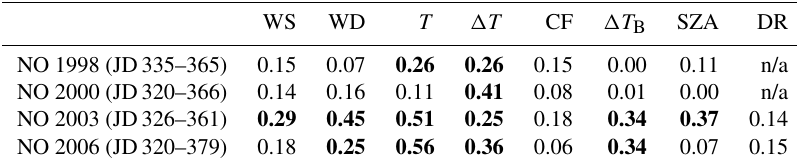
Table A1. Regression ( r 2 ) of meteorological variables with NO. r 2 > 0 . 2 in bold. No trends were removed. WS WD T (cid:49)T (cid:49)T B